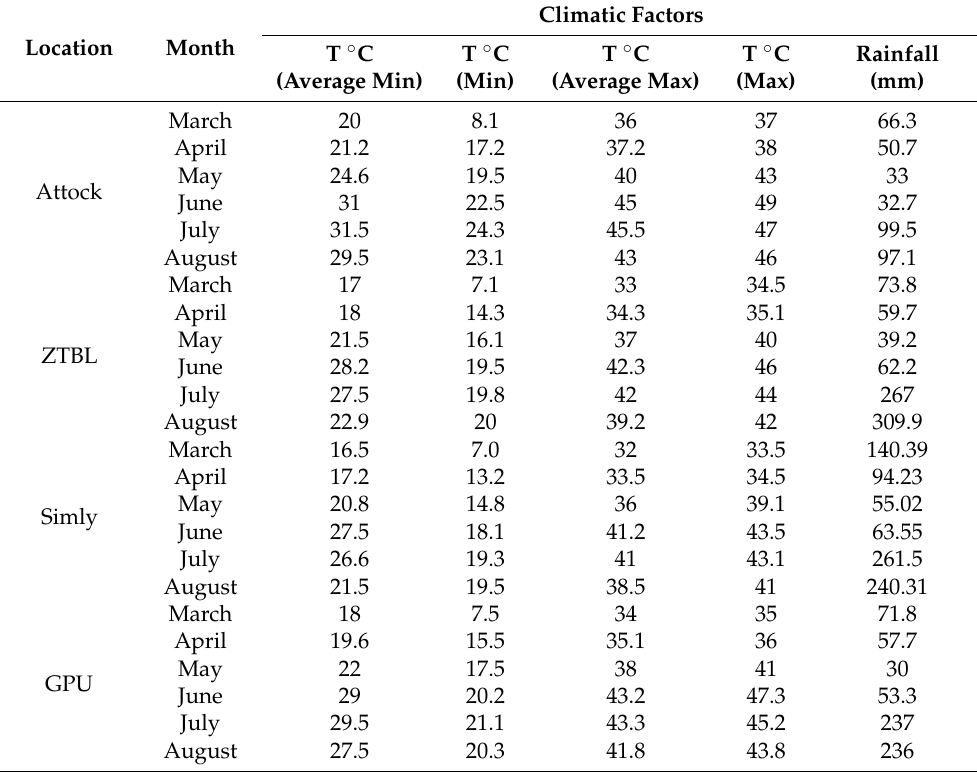
Table 2. Climatic factors recorded at different